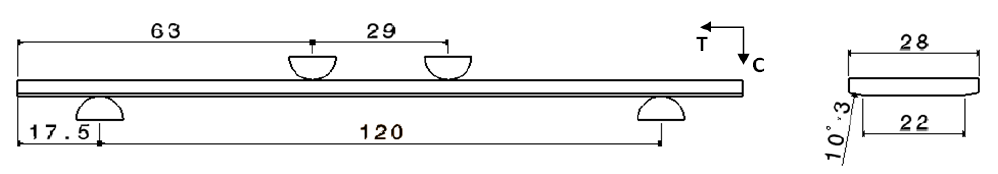
Figure 3. Fatigue specimens geometry (values are given in